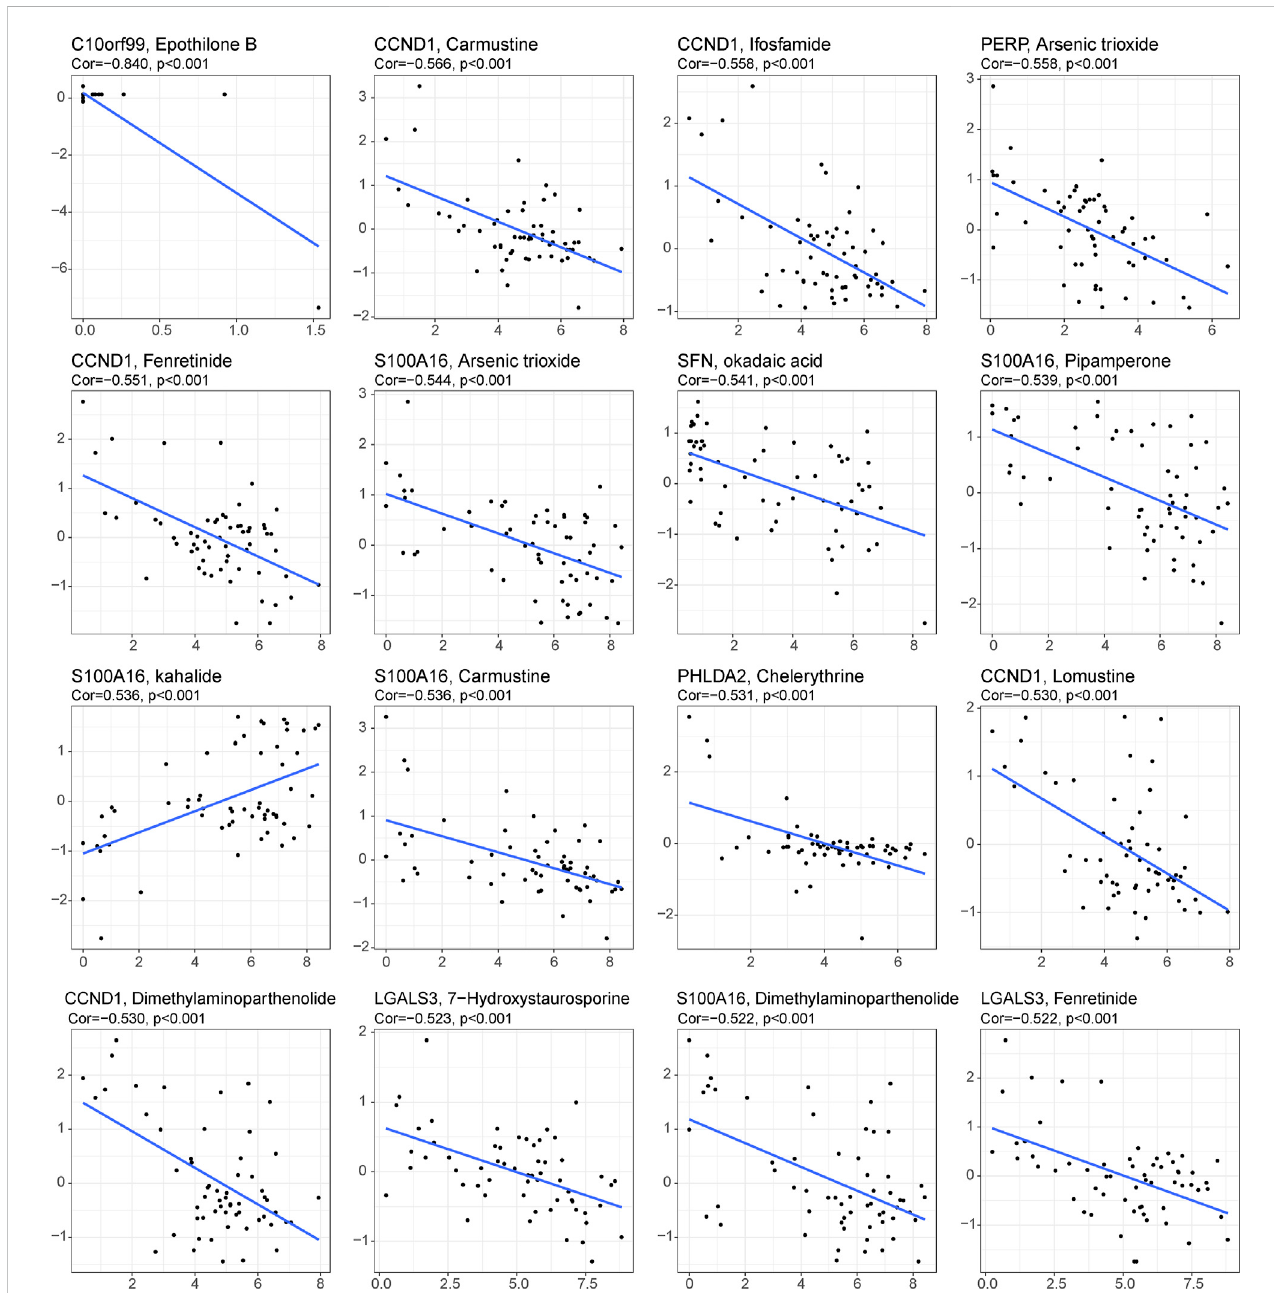
FIGURE 6 Drug prediction for the 29 single-cell marker genes. Sixteen representative scatter plots of the relationship between drug sensitivity and the expression levels of the 29 genes.